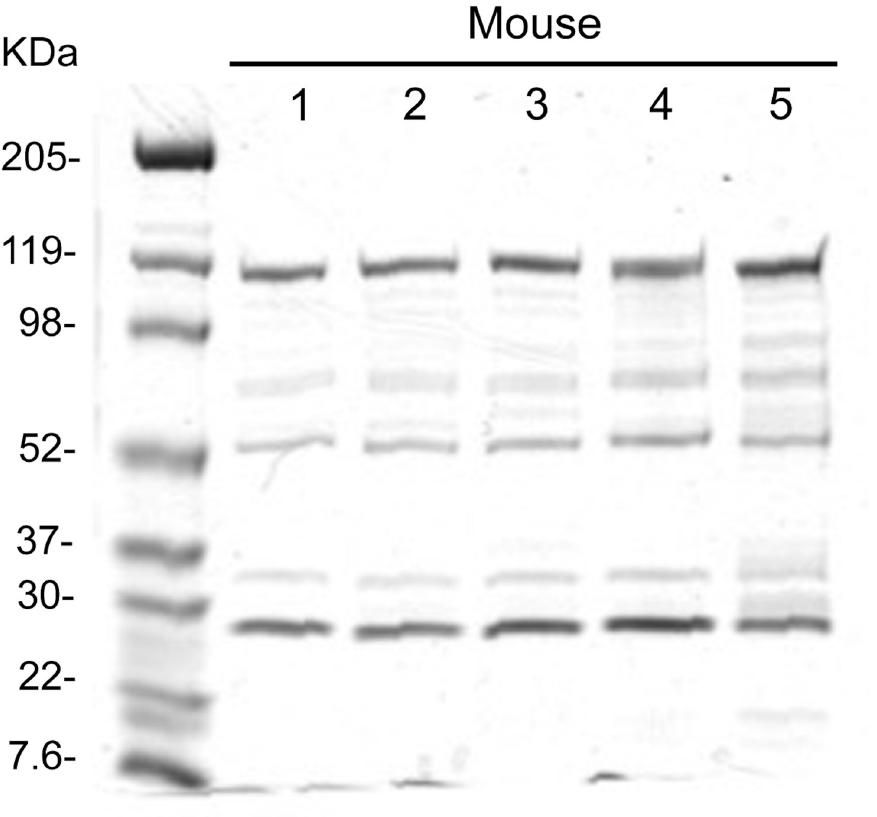
Fig 1. SDS-PAGE analysis of the rH17d-containing Ad5 vectors. In the assay, 10 10 VP of CsCl-purified viral vectors were subjected to SDS-PAGE analysis. Gelcode staining of the viral capsid proteins showed that viral particles of the rH17d’-containing Ad5 vectors had correct protein composition, as compared to the control (unmodified and His 6 - modified) vectors. The relative intensities of the protein bands in each lane (virus sample) were consistent with viral titration data (physical titer values). M: molecular weight marker; Lanes: 1—Ad5 (GL); 2—Ad5.HVR2-His 6 (GL); 3— Ad5.HVR2-rH17d’ (GL); 4—Ad5.HVR5-His 6 (GL); 5—Ad5.HVR5-rH17d’